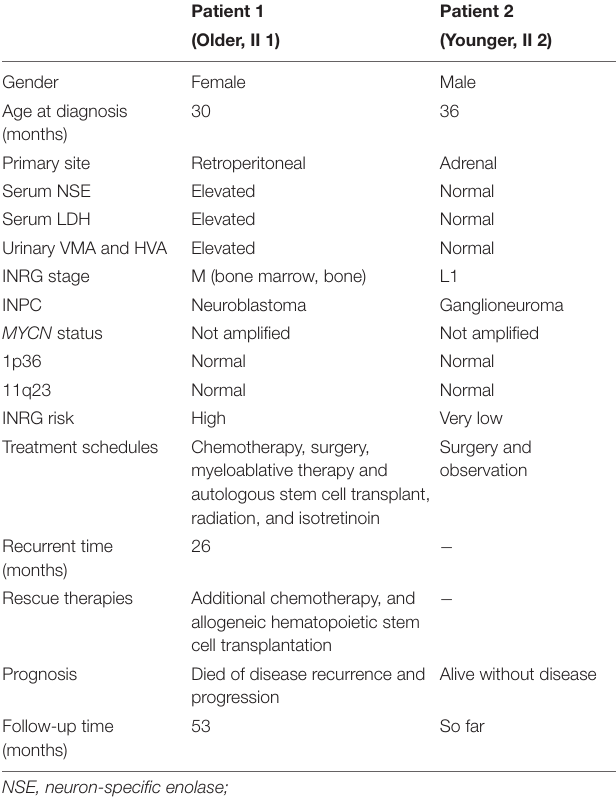
TABLE 1 | Clinical characteristics of two patients with peripheral neuroblastic